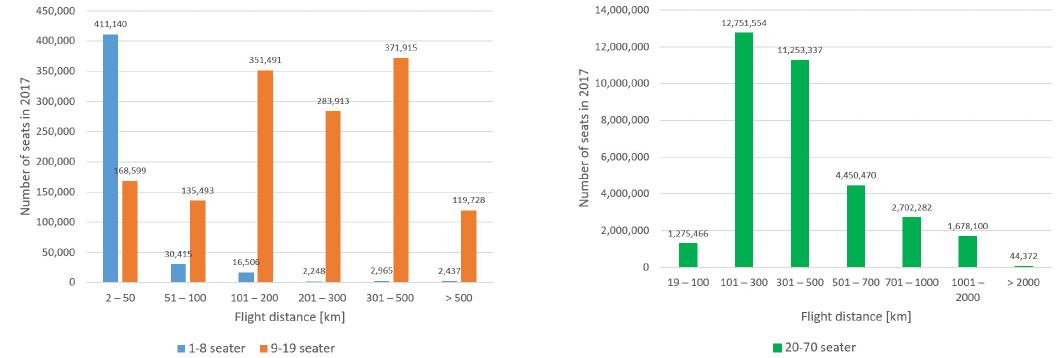
Figure 5. Number of passengers for 1–8 (blue), 9–19 (orange), and 20–70 (green) seater aircraft in the European region in 2017.